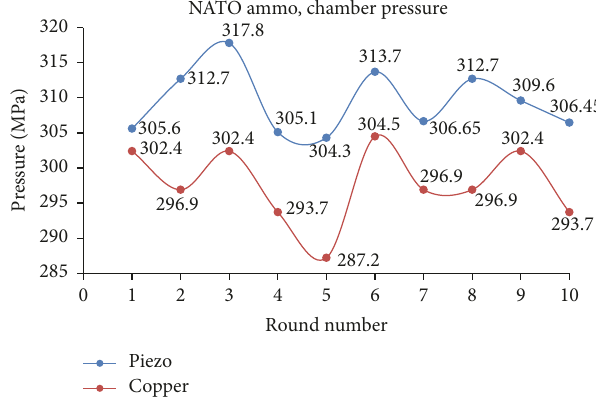
Figure 27: Chamber pressure measured with copper crusher and piezo sensor simultaneously using standard NATO